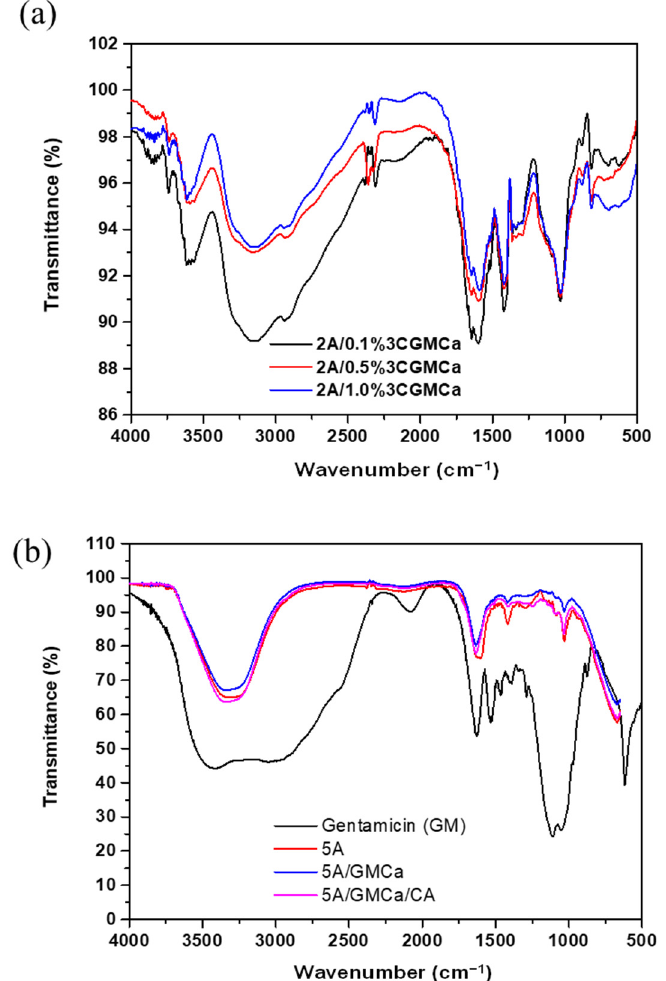
Figure 2. FTIR spectra of ( a ) gentamicin-loaded alginate-chitosan (2A/x%3CGMCa; x = 0.1, 0.5, 1.0) beads with different chitosan content. ( b ) Alginate beads: alginate-only (5A), with gentamicin (5A/GMCa), and with gentamicin and then crosslinked with citric acid (5A/GMCa/CA).